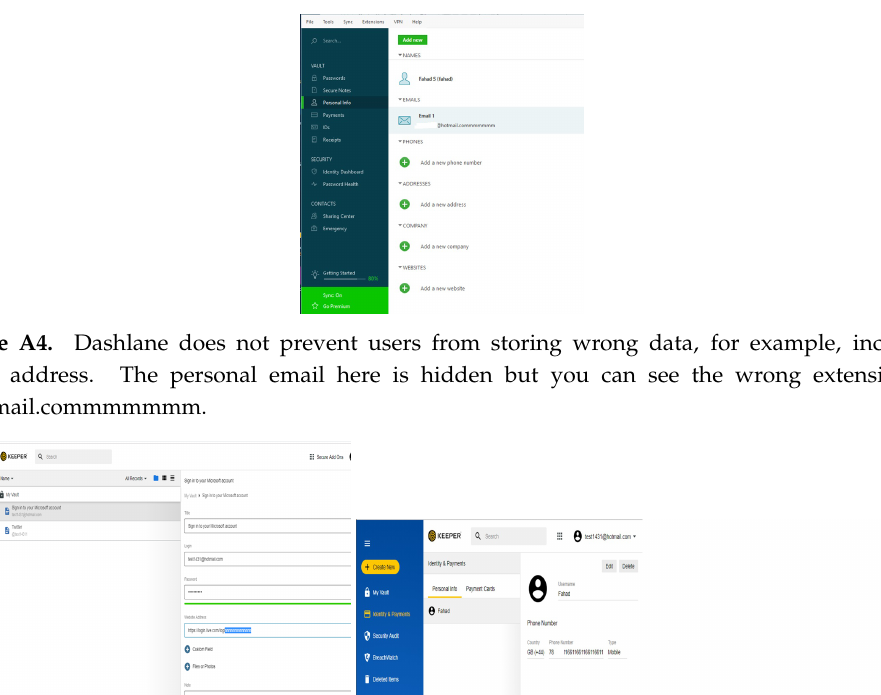
Figure A3. LastPass does not prevent users from storing wrong data, for example, incorrect URL, alphabetic instead of numerical characters.